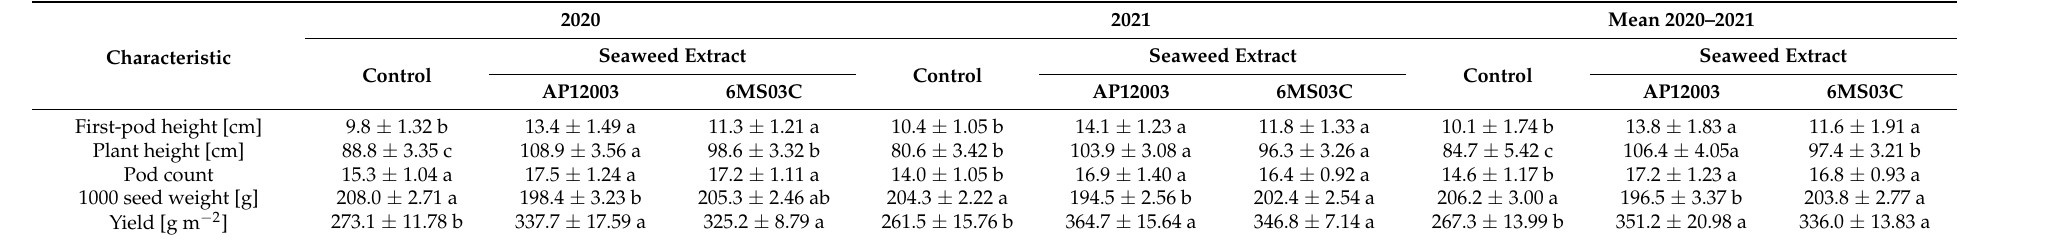
Table 2. Soybean biometrics (mean ± SD).